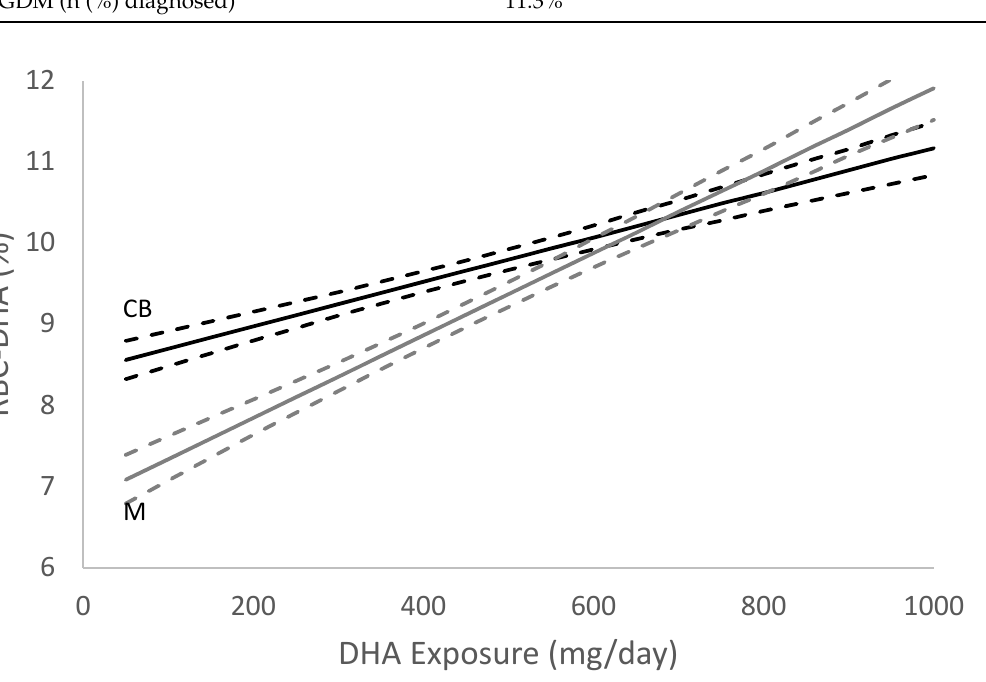
Figure 2. DHA Equilibrium (EQ) Estimate ( n = 1145). Graphical representation of the EQEQ location with point estimates and 95% confidence intervals for DHA exposure. RBC-DHA is the red blood cell DHA %, dark line is the regression estimate of cord blood RBC-DHA (CB) and grey line is the regression estimate of maternal RBC-DHA (M) as a function of DHA exposure. The dashed lines are regression 95% intervals.